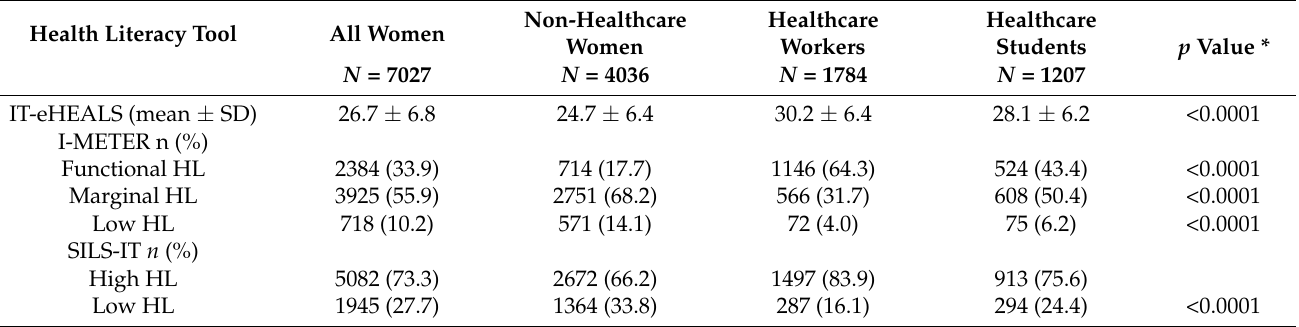
Table 3. Health literacy (HL) according to IT-eHEALS, I-METER, and SILS in non-healthcare women vs. non-healthcare workers/students.